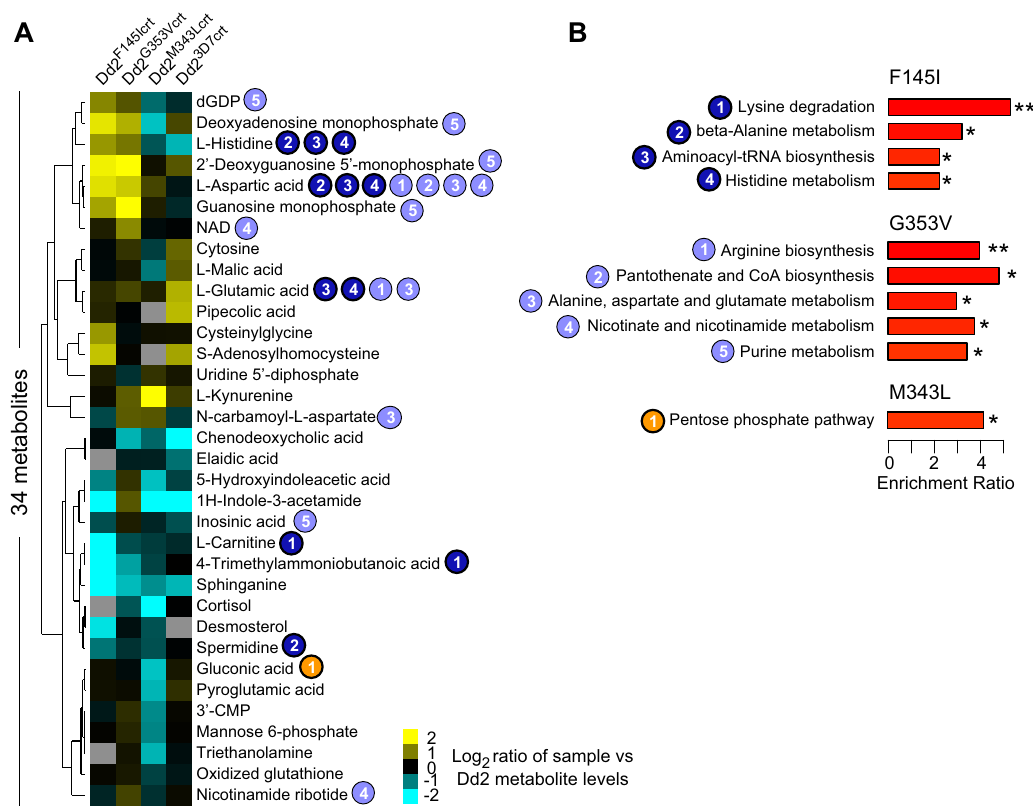
Fig 4. Detected metabolites and pathways altered in PPQ-resistant mutant pfcrt lines. ( A ) Heatmap of 34 metabolites identified in at least 3 of the 4 isogenic Dd2 lines differing in their PfCRT isoform, with metabolite levels expressed as a log 2 ratio for each line compared to Dd2 (aggregated group of Dd2 and Dd2 Dd2crt ). Undetected metabolites are indicated in grey. Numbers correspond to pathways shown in (B). ( B ) List of KEGG metabolic pathways showing significant differences in metabolite abundance for each mutant line compared with the aggregated Dd2 data ( � p < 0.05; �� p < 0.01; Q-statistic calculated from a generalized linear model).